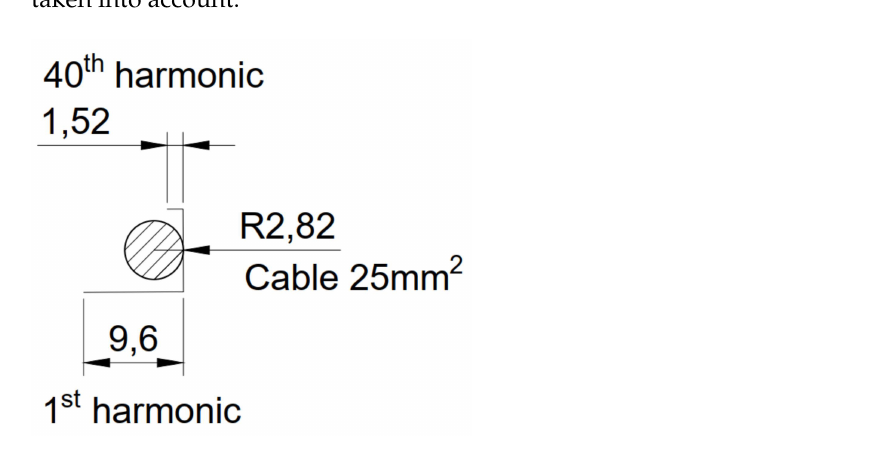
Figure 9. The current penetration depth (in mm) for the 1st and 40th current harmonics and the cable conductor with 25 mm 2